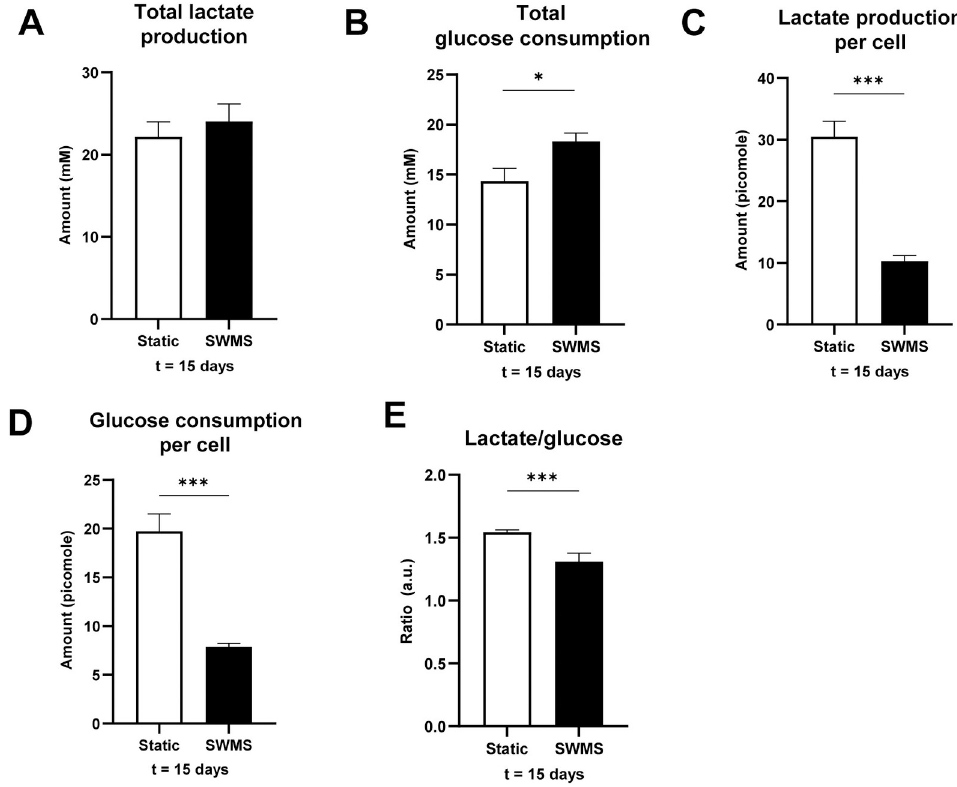
Fig 7. Lactate production and glucose consumption by HT29-MTX-E12 grown under static and SWMS conditions. A) Total lactate (micromole) produced per well in medium collected from apical and basolateral compartments of HT29-MTX-E12 cells grown under static or SWMS conditions, at t = 15 days. B) Total glucose (micromole) consumed per well from medium collected from apical and basolateral compartments of HT29-MTX-E12 grown under static and SWMS conditions, at t = 15 days. C) Glucose consumption (picomole) per cell by HT29-MTX-E12 grown under static and SWMS conditions at t = 15 days. D) Lactate production (picomole) per cell by HT29-MTX-E12 grown under static and SWMS conditions at t = 15 days. E) Ratio of lactate produced glucose consumed per cell in HT29-MTX-E12 grown under static and SWMS conditions at t = 15 days. � p < 0.05; �� p < 0.01; ��� p < 0.001, n = 3 biological